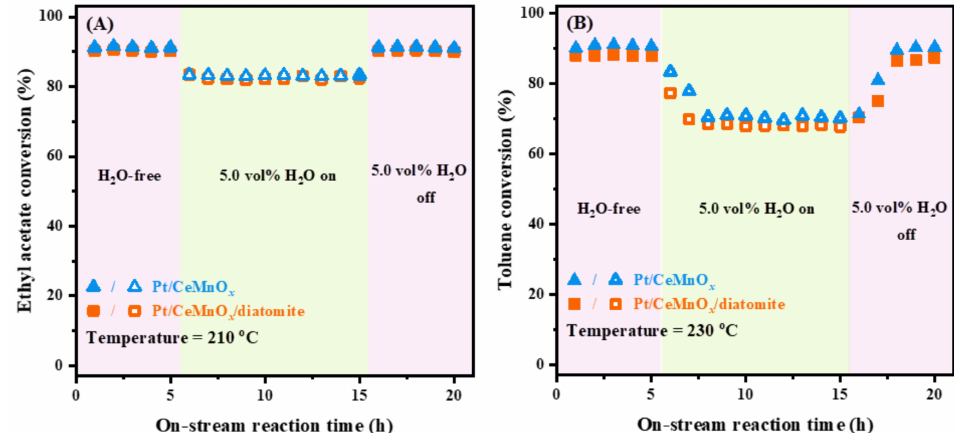
Figure 11. Effect of 5.0 vol% H 2 O on catalytic activity of Pt/CeMnO x /diatomite and Pt/CeMnO x for ( A ) ethyl acetate oxidation at 210 ◦ C or ( B ) toluene oxidation at 230 ◦